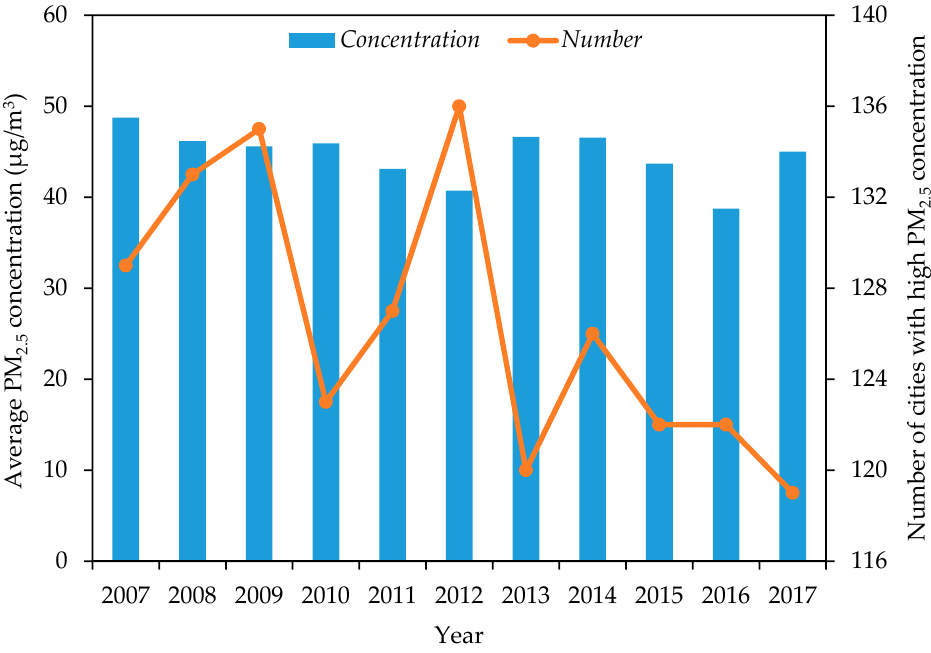
Figure 2. China’s PM 2.5 pollution status from 2007 to 2017.